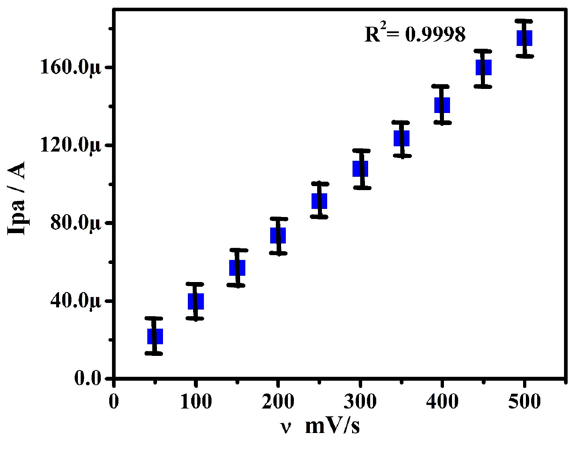
Figure 7. Graph of Ipa vs SR of PA (0.1 mM) in PBS (0.2 M, pH 7.4).